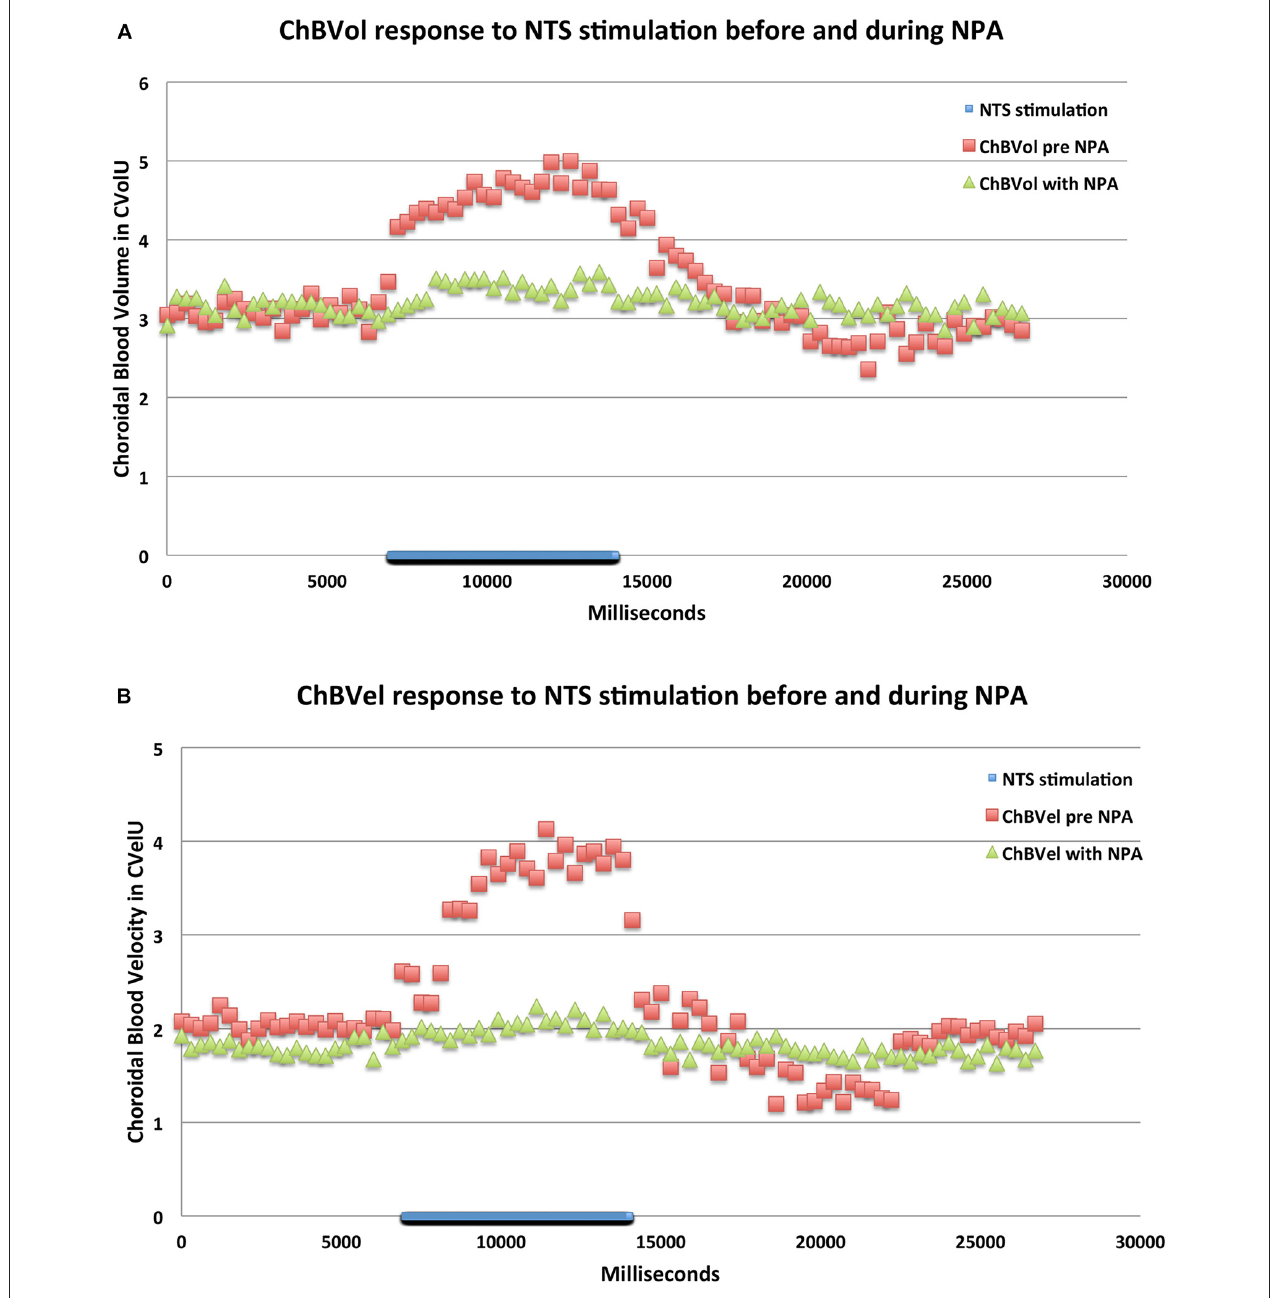
FIGURE 9 | Graphs showing the mean ChBVol (A) and ChBVel (B) responses to stimulation at effective NTS sites prior to and after NPA administration ( n = x ). The blue bar marks the stimulation period. Each data point is the mean for 333 ms. ChBVol and ChBVel are expressed in relative units. Note that NPA significantly reduces both ChBVol and ChBVel responses to NTS